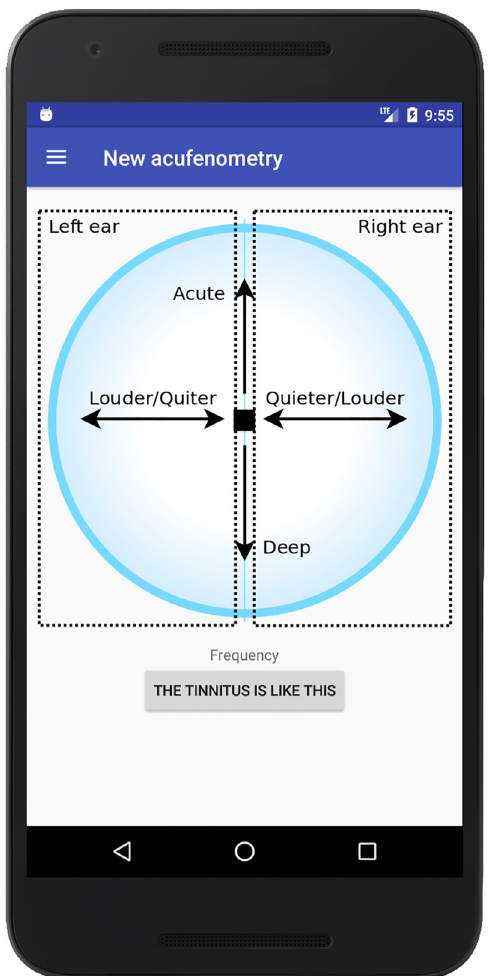
Figure 8: The improved interface for the acufenometry